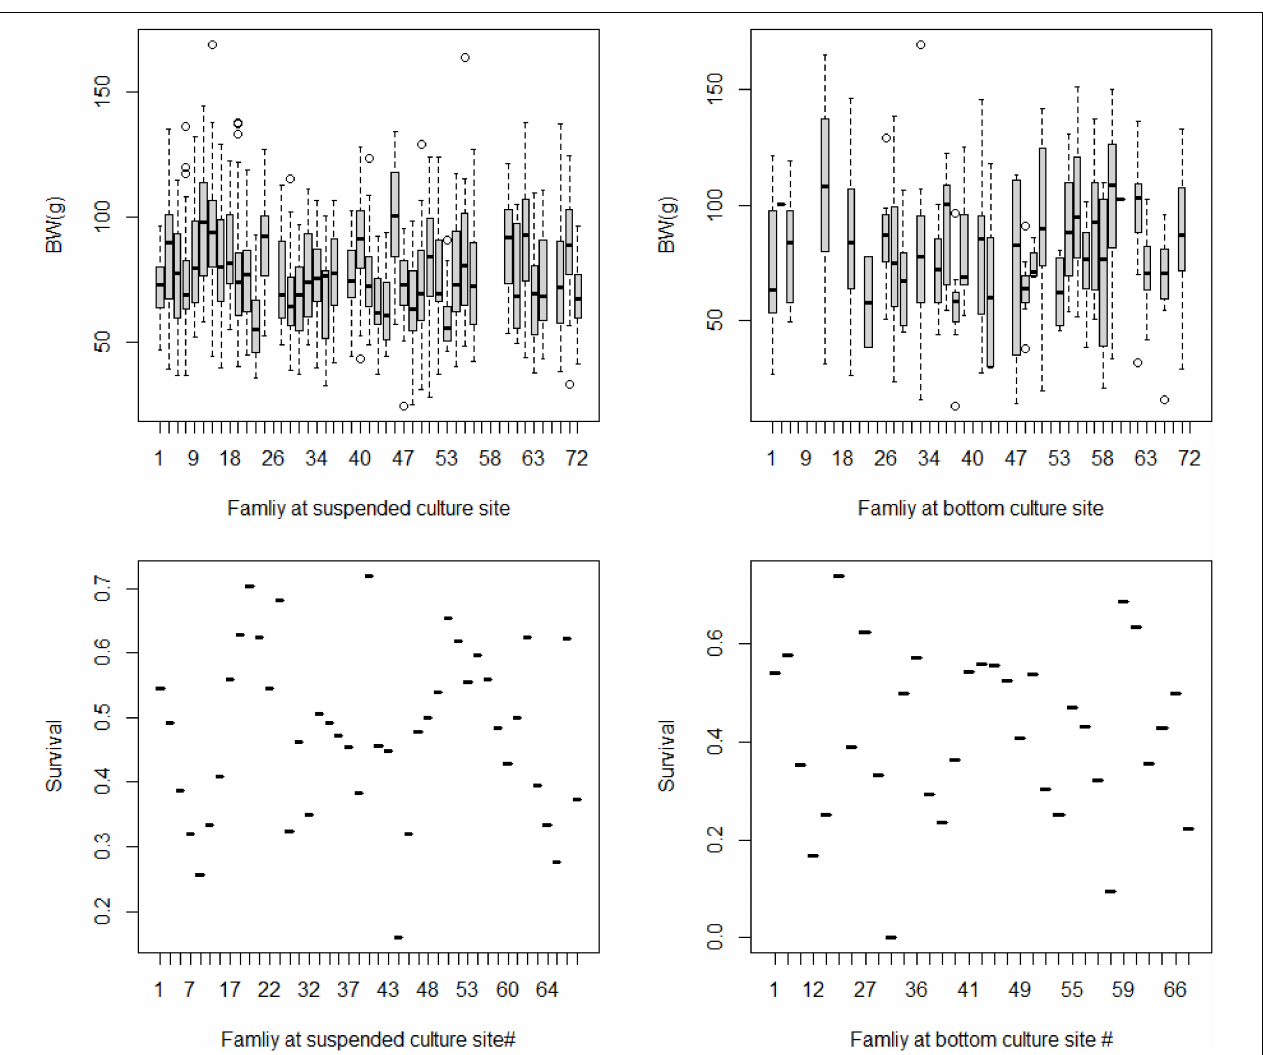
FIGURE 2 | Body weight (BW, g) and survival rate (Survival, × 100%) of yesso scallop full-sib families at suspended and bottom culture